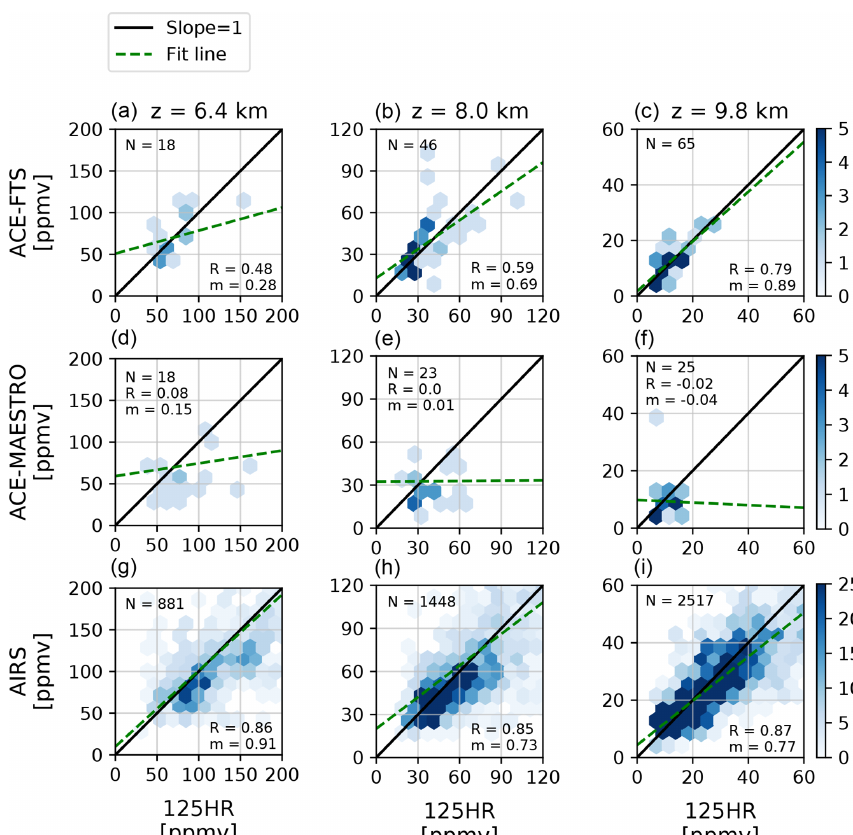
Figure 8. Correlation plots for the ACE-FTS, ACE-MAESTRO, and AIRS satellite measurements vs. 125HR. The number of points in a given hexagon is colour-coded to show the density of the points. The scale at each end of a row shows the colour map used for that row. Solid black lines are 1:1 reference lines (i.e. slope = 1); green dashed lines are lines of linear best fit. N is the number of coincident measurements for comparisons between the instruments at that altitude. R is the correlation coefficient. m is the slope of the best-fit line. Table 3. Summary of satellite vs. radiosonde comparison results. SEM refers to the standard error in the mean, i.e. σ √ Instrument (retrieval